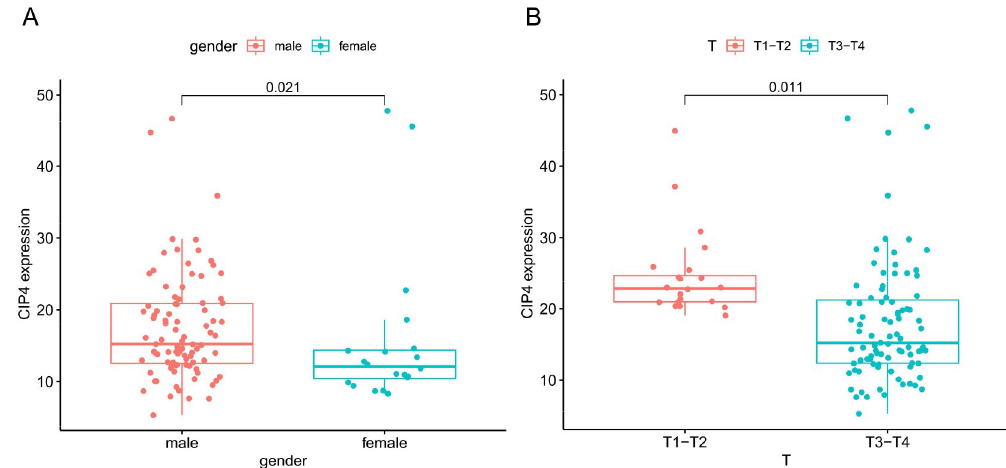
Fig 3. Relationship between CIP4 expression and clinical characteristics. (A) Gender; (B) Tumor stage.